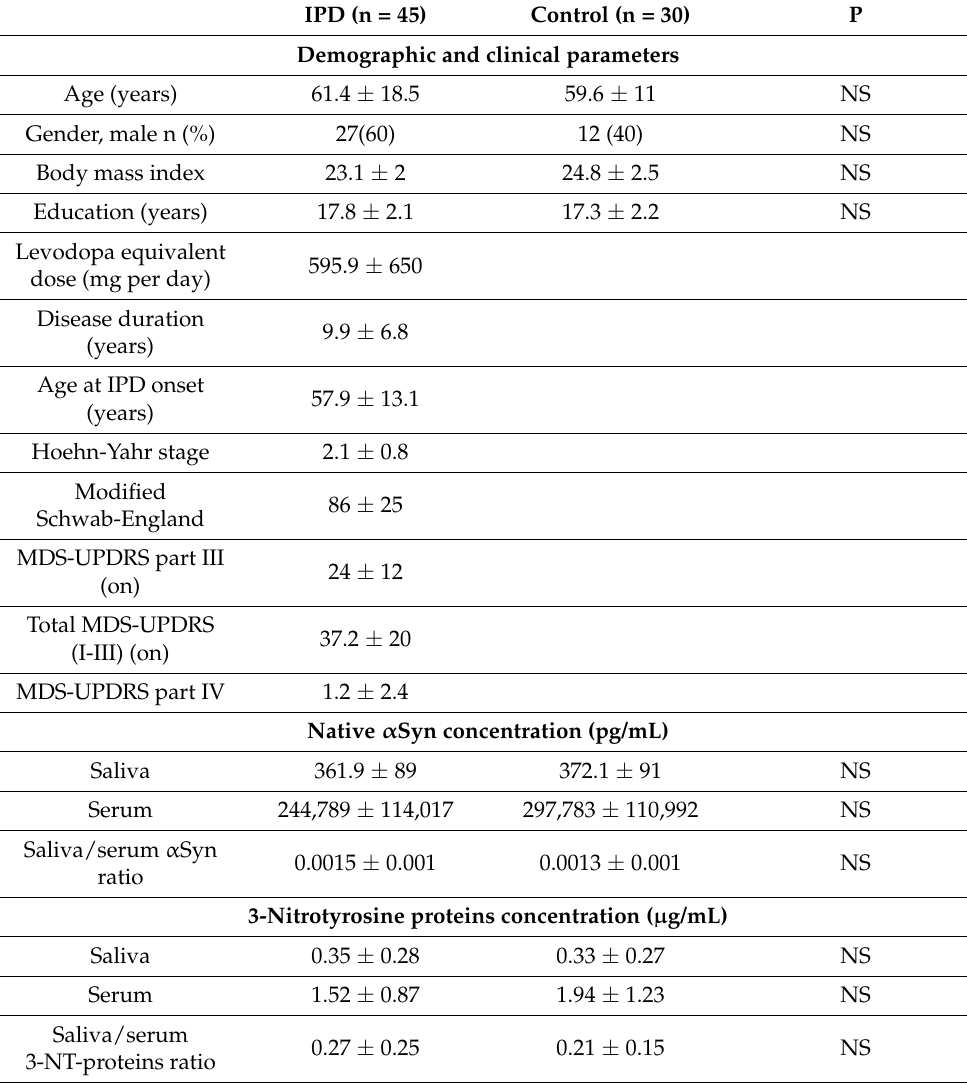
Table 1. Demographic and clinical parameters, as well as concentration of salivary and serum α Syn and 3-nitrotyrosine proteins, in patients with IPD and control